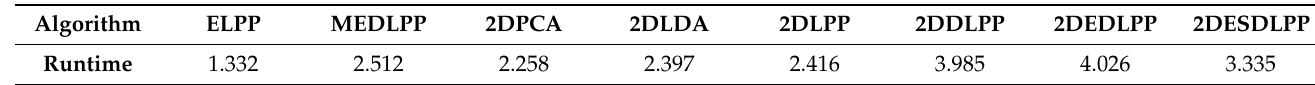
Table 5. The runtime(s) of eight different algorithms when the number of training samples in the Yale database is